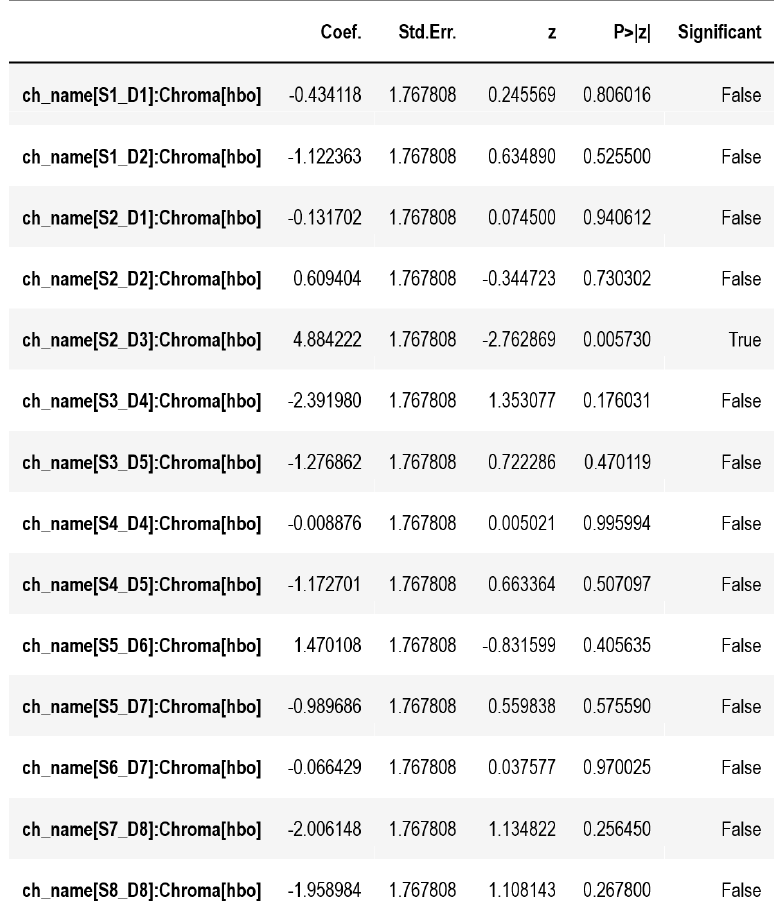
Beta coefficients of second level of GLM contrast “reading task versus a word format of calculation” in high level